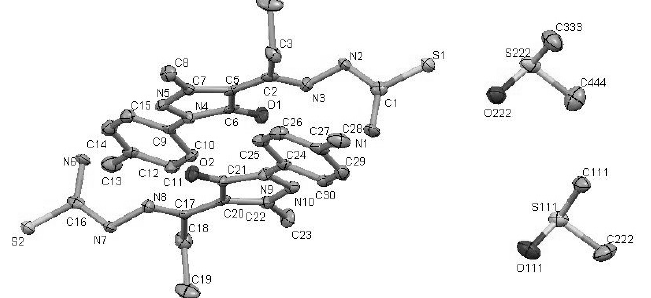
Figure 2. Molecular structure of compound